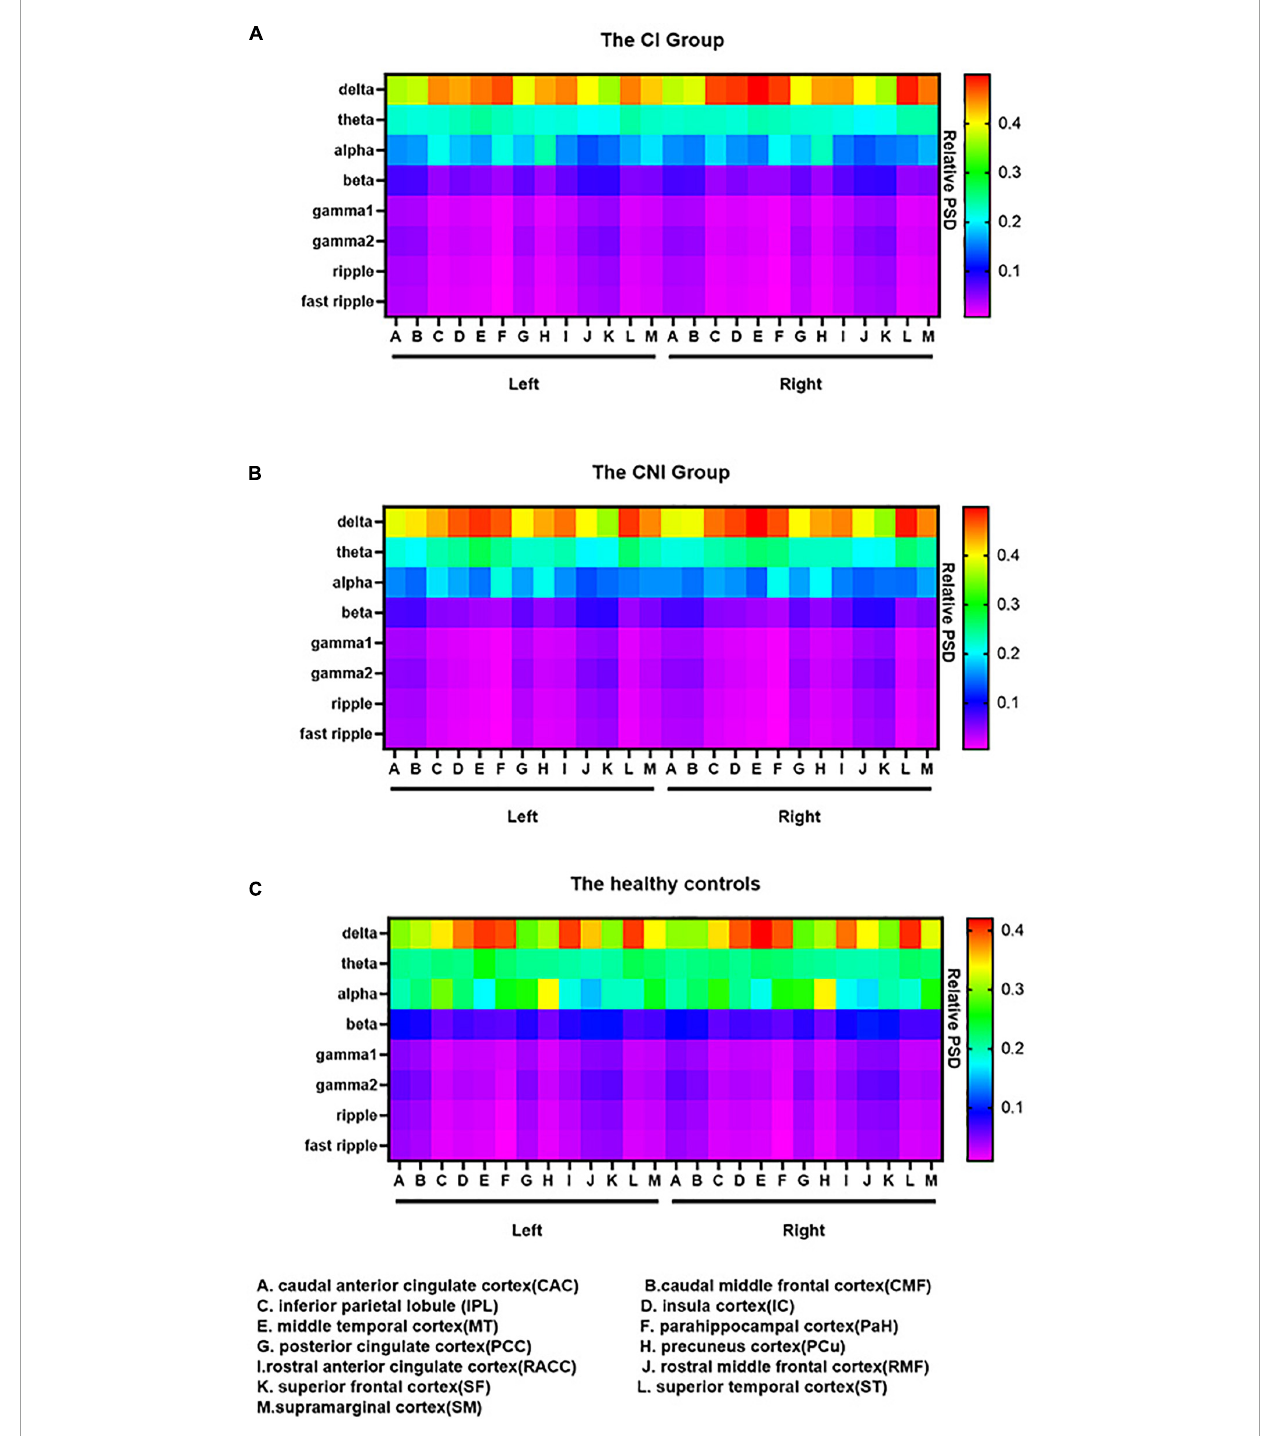
FIGURE3 The relative spectral power of 26 brain regions from delta to fast ripple bands in (A) the cognitive impairment (CI) group, (B) the cognitive nonimpairment (CNI) group, and (C) healthy controls. The data were color-coded. In (A) the CI group and (B) the CNI group, delta band had a diffuse enhancement within bilateral IPL, IC, MT, PaH, PCu, RACC, ST and SM. In (C) the healthy controls, the alpha band had a significant diffuse enhancement, especially within bilateral PCu. PSD = relative power spectral